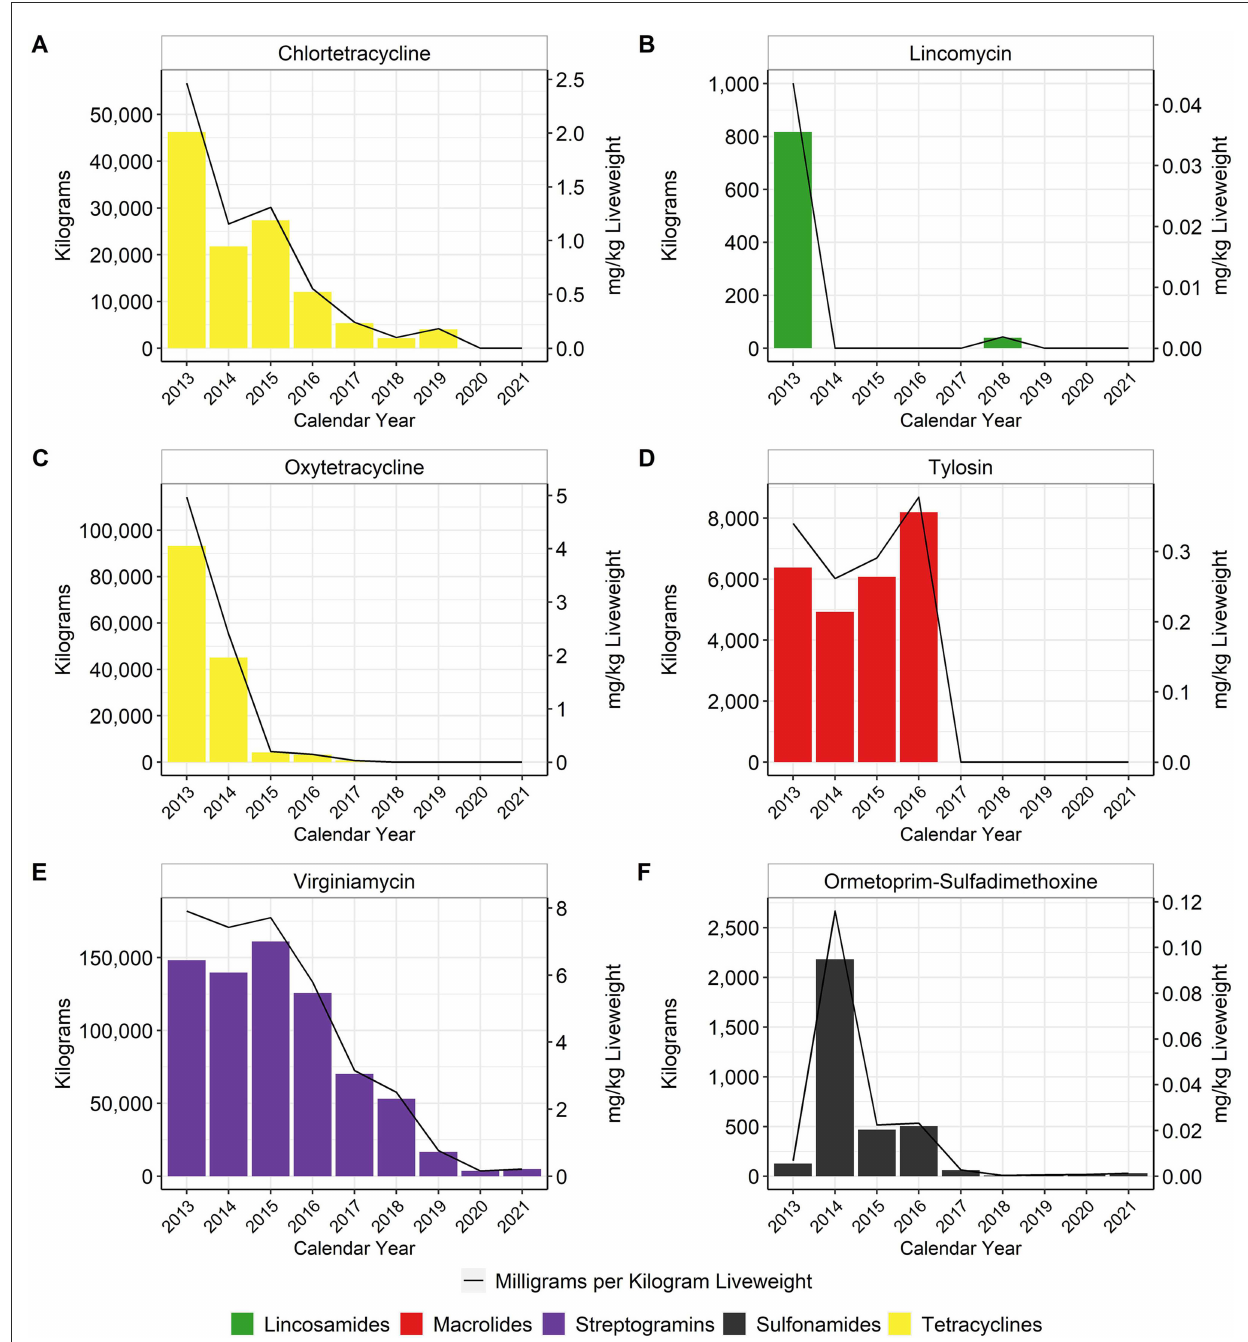
FIGURE4 Medically Important antimicrobials chlortetracycline (A) , lincomycin (B) , oxytetracycline (C) , tylosin (D) , virginiamycin (E) , and ormetoprim-sulfadimethoxine (F) used in broiler feed, 2013–2021. Total kilograms are shown by the bars (left Y-axis) and total mg/kg liveweight are shown by the line (right